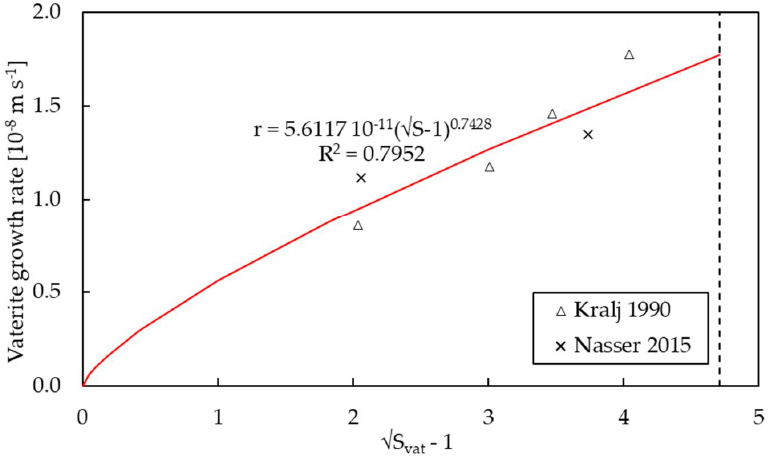
Figure 3. Growth data calculated from Kralj and Nasser, providing a growth rate that is near first order. The dashed line indicates where the supersaturation of ACC starts.